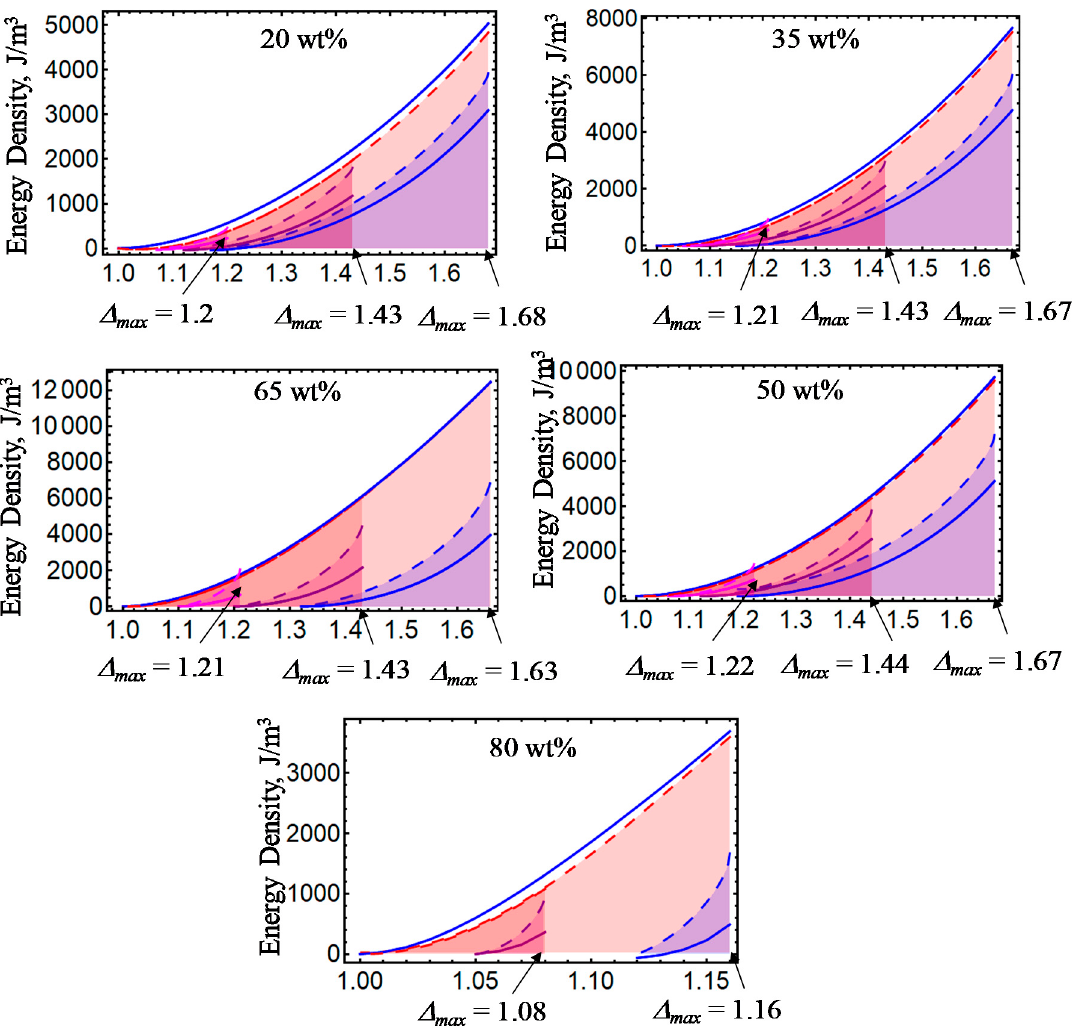
Figure 3. Energy dissipation energy curves for isotropic magnetorheological material samples subjected to loading and unloading cycles with B = 52.2 mT.